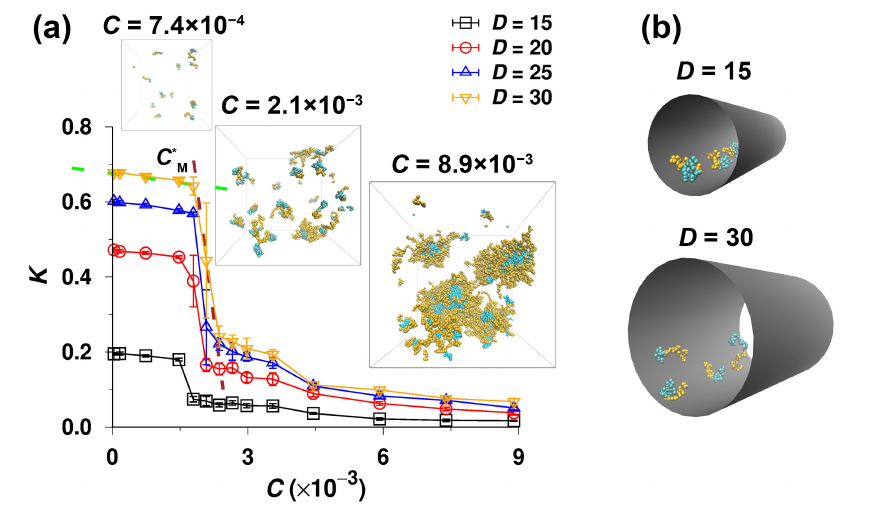
Figure 2. ( a ) Partition coefficient, K , of A32B32 copolymers partitioning between the bulk and the pore, as a function of total concentration of beads, C , for various pore diameters, D . Typical snapshots of copolymers in the bulk corresponding to the partitioning ( D = 30) at the low ( C = 7.4 × 10 − 4 ), medium ( C = 2.1 × 10 − 3 ) and high ( C = 8.9 × 10 − 3 ) concentrations are also given, where the orange and cyan beads represent the solvophilic (A) and solvophobic (B) segments, respectively. ( b ) Typical snapshots of copolymers in the cylindrical pores of D = 15 and 30. The concentrations of chains in the pores correspond to the partitioning between two phases at C = 8.9 × 10 − 3 . All snapshots were rendered with VMD [70]